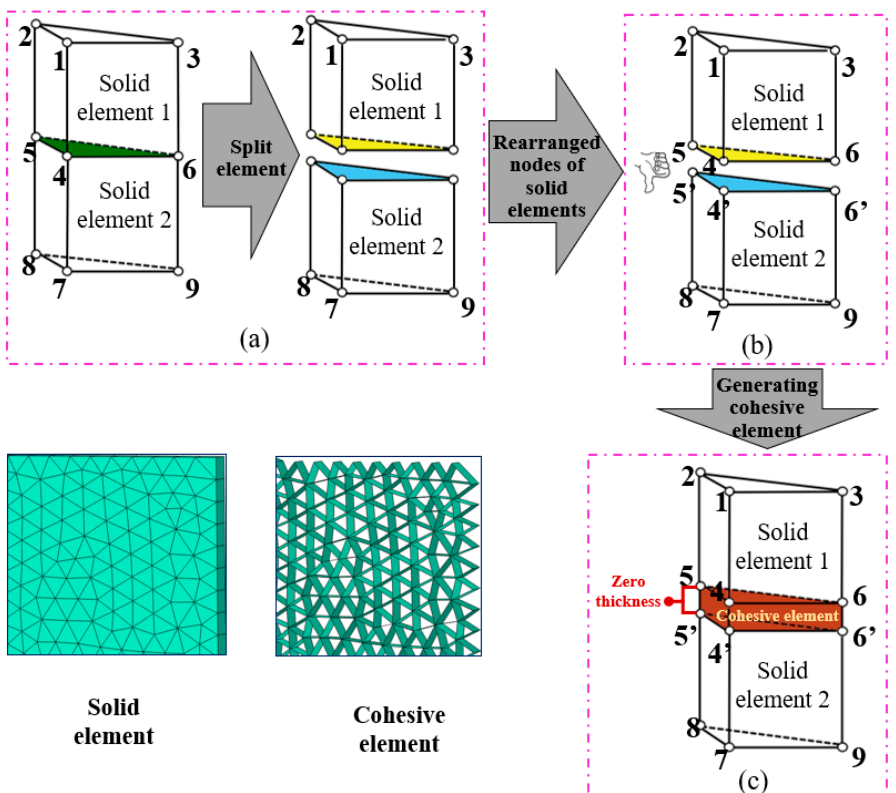
Figure 3. The zero-thickness cohesive element generation process. ( a ). schematic representation of discretize the solid elements; ( b ) schematic diagram of sorting of cohesive element nodes; ( c ) schematic diagram of the insertion of a zero-thickness cohesive element